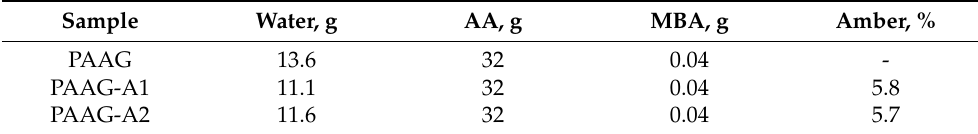
Table 1. Composition of reagents used for synthesis of PAAG